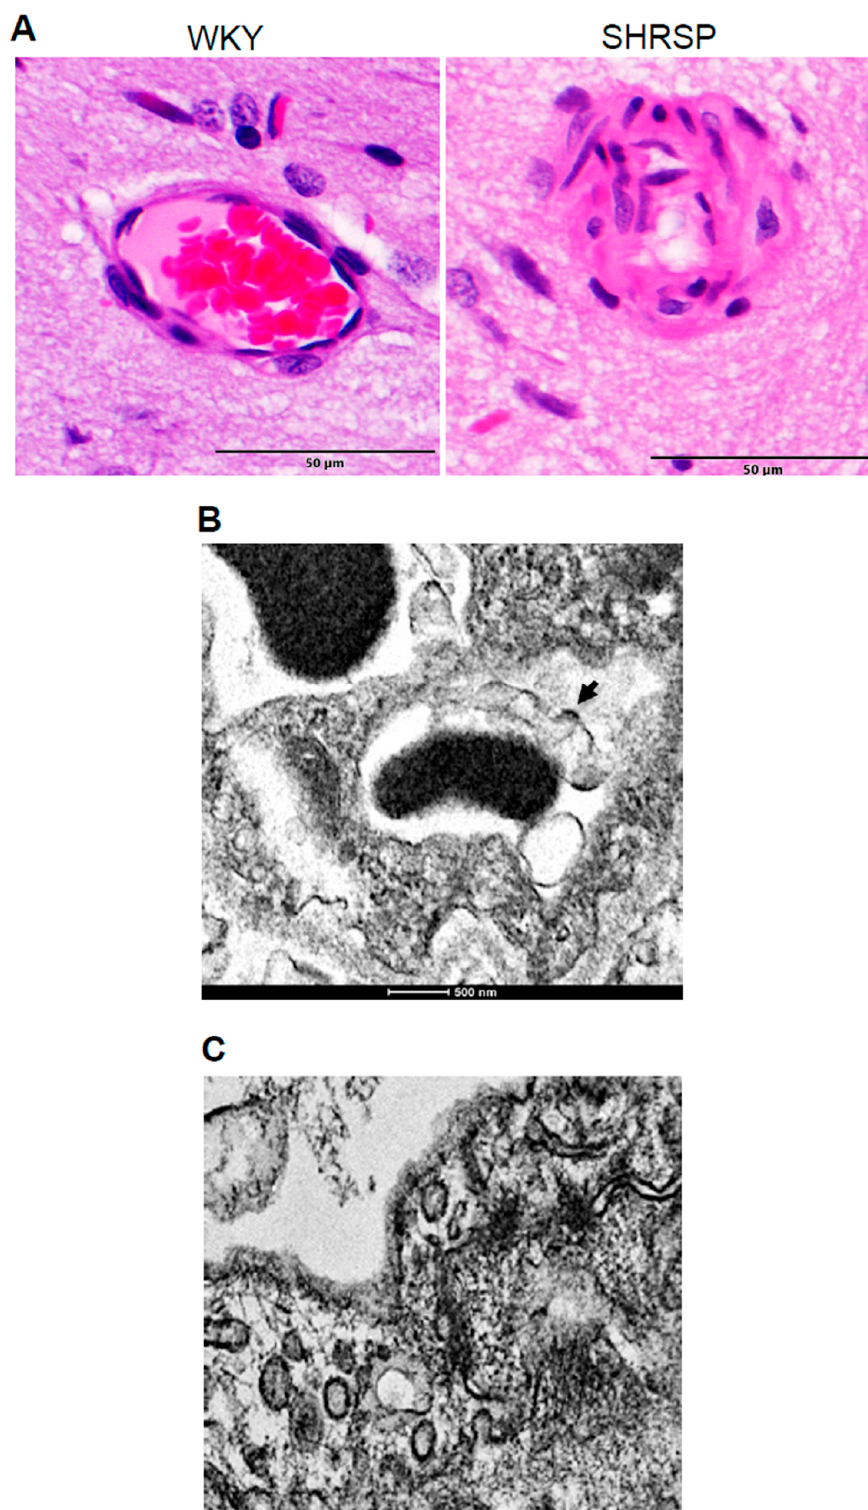
Figure 6. Brain vascular hyalinosis in SHRSP rats. ( A ) H&E staining images of the brain vessels of Wistar–Kyoto (WKY) control rats and SHRSP rats at 8 weeks of age. Magnifications, × 400. ( B ) TEM image of the endothelial cell bulge protrusion into the lumen of the vasa vasorum in SHRSP rats. Magnification, × 14,500. ( C ) TEM image of endocytic vesicles in the endothelium of the vasa vasorum of SHRSP rats. Magnification, × 18,000. Representative images of n = 4 rats per group.